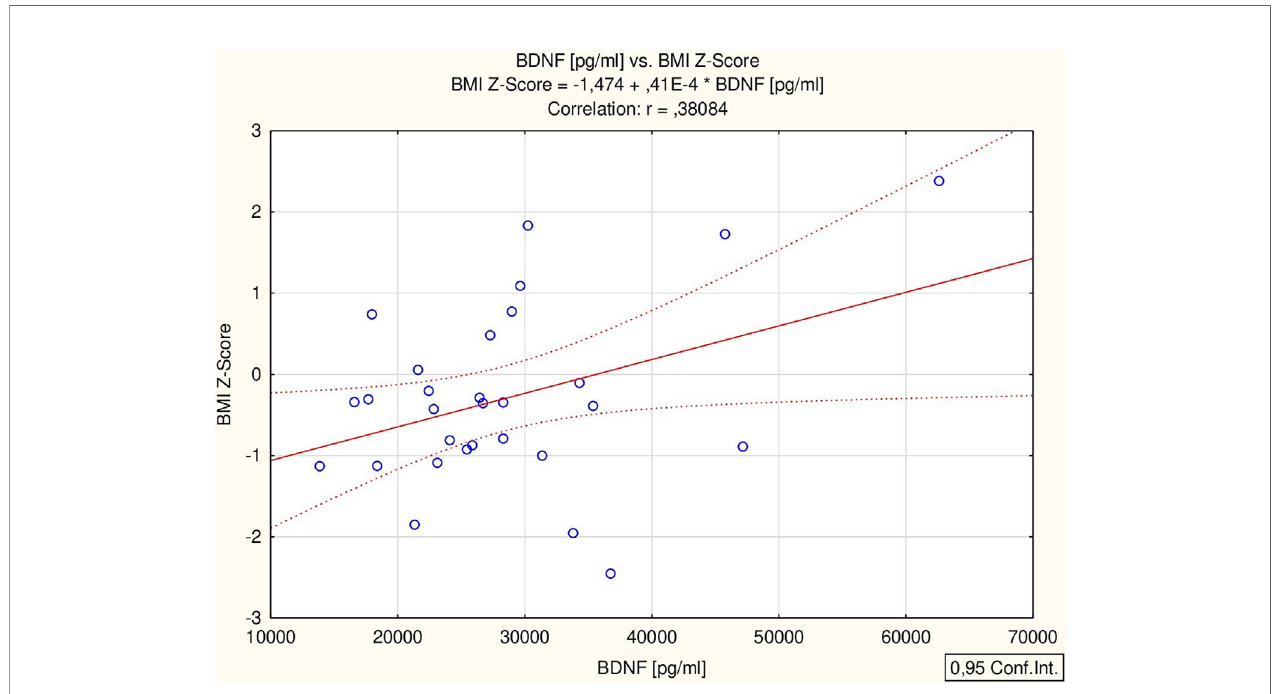
FIGURE 1 | Correlation of BDNF with BMI Z-score; body mass index Z-score; BDNF, brain-derived neurotrophic